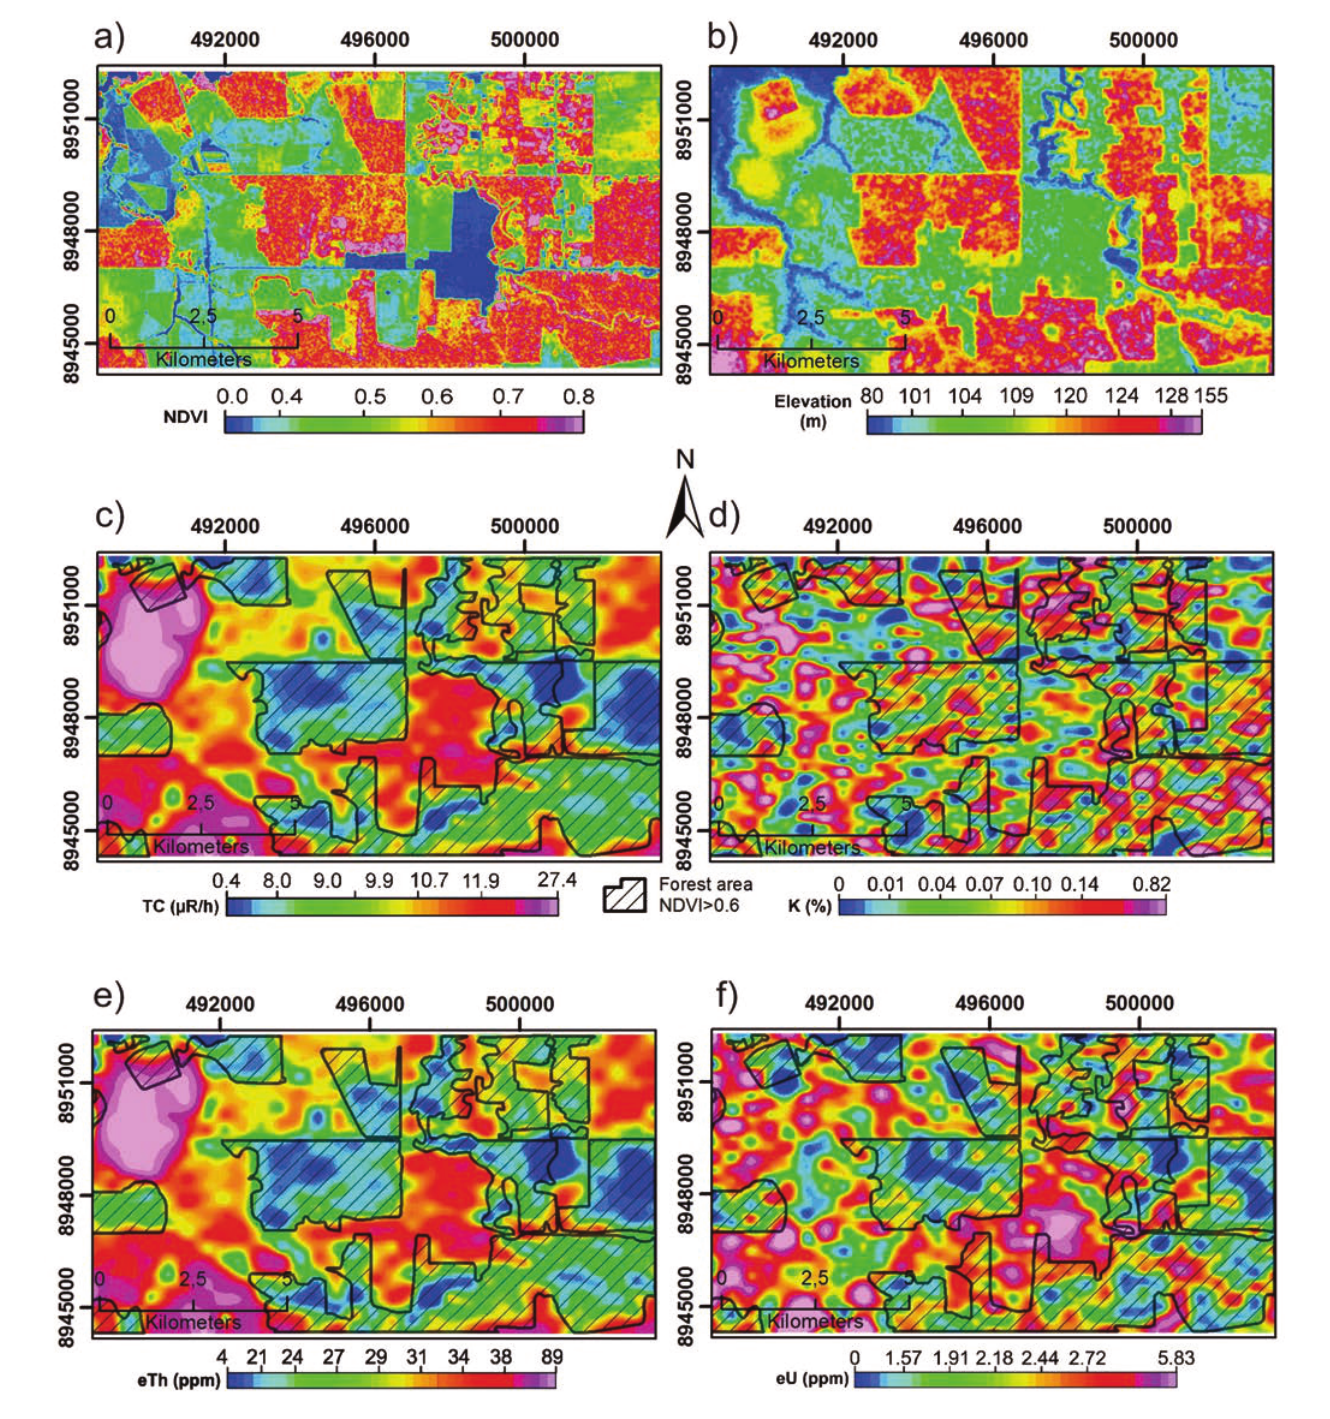
Figure 5 - Maps based on interpolation of values calculated by the Minimum Curvature method. The hatched areas of wooded contour were drawn by delimiting NDVI values greater than 0.6. The respective color bar is below each map; a) 30-meter pixel NDVI map; b) 30-meter pixel SRTM DEM; c) Total Count map with 125-m pixel, as well as the next; d) K (%) map; e) eTh map; f) eU